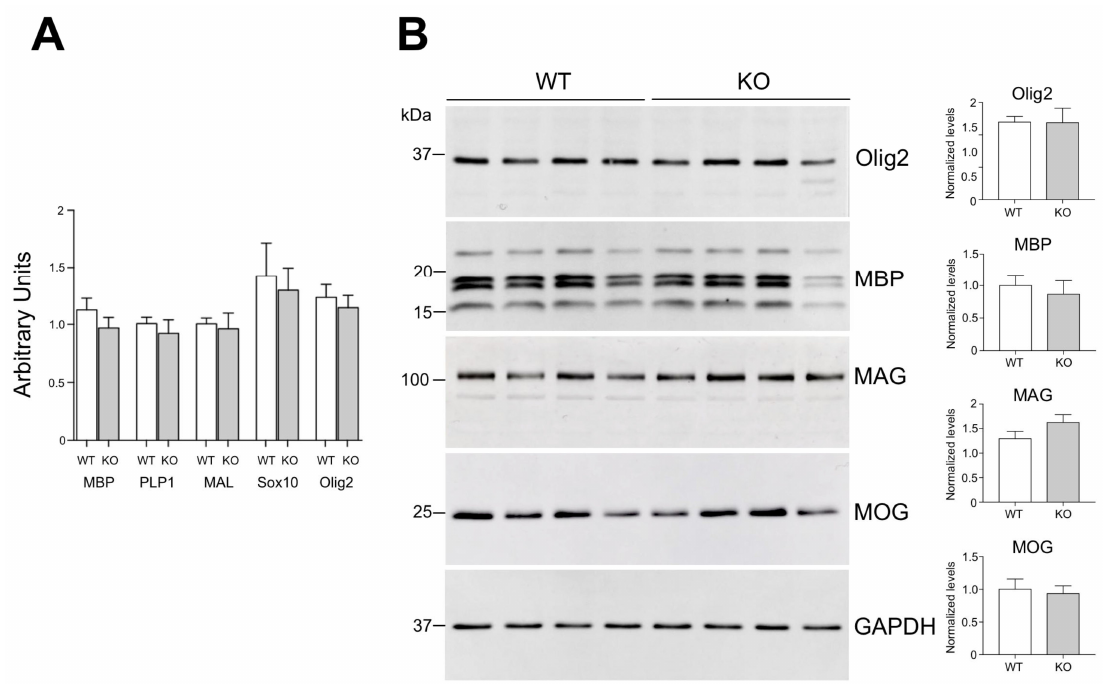
Figure 2. Oligodendrocyte/myelin markers expression in cerebral cortex. ( A ) mRNA expression levels of OLG lineage markers Olig2 and Sox10, and of mature-myelinating OLG marker MBP, PLP1 and MAL measured by RT-PCR. No significant differences for any of the markers were observed when comparing WT to Lgals4-KO (KO) mice according to the Student’s t -test. Values are means of normalized mRNA expression levels + SEM (MBP, n = 11; Olig2, n = 12; Sox10, n = 6; PLP1 and MAL, n = 5). ( B ) Protein levels of myelin markers measured by WB. Cortical extracts from 4 WT animals (4 lines on the left) and 4 Lgals4-KO animals (4 lines on the right) were analyzed. GAPDH was used as loading control. In graphs, values are means of normalized densitometric measures + SEM. In agreement with the results in ( A ), no significant differences were observed between WT and Lgals4- KO animals for the protein expression of any of the assayed markers according to the Student’s t